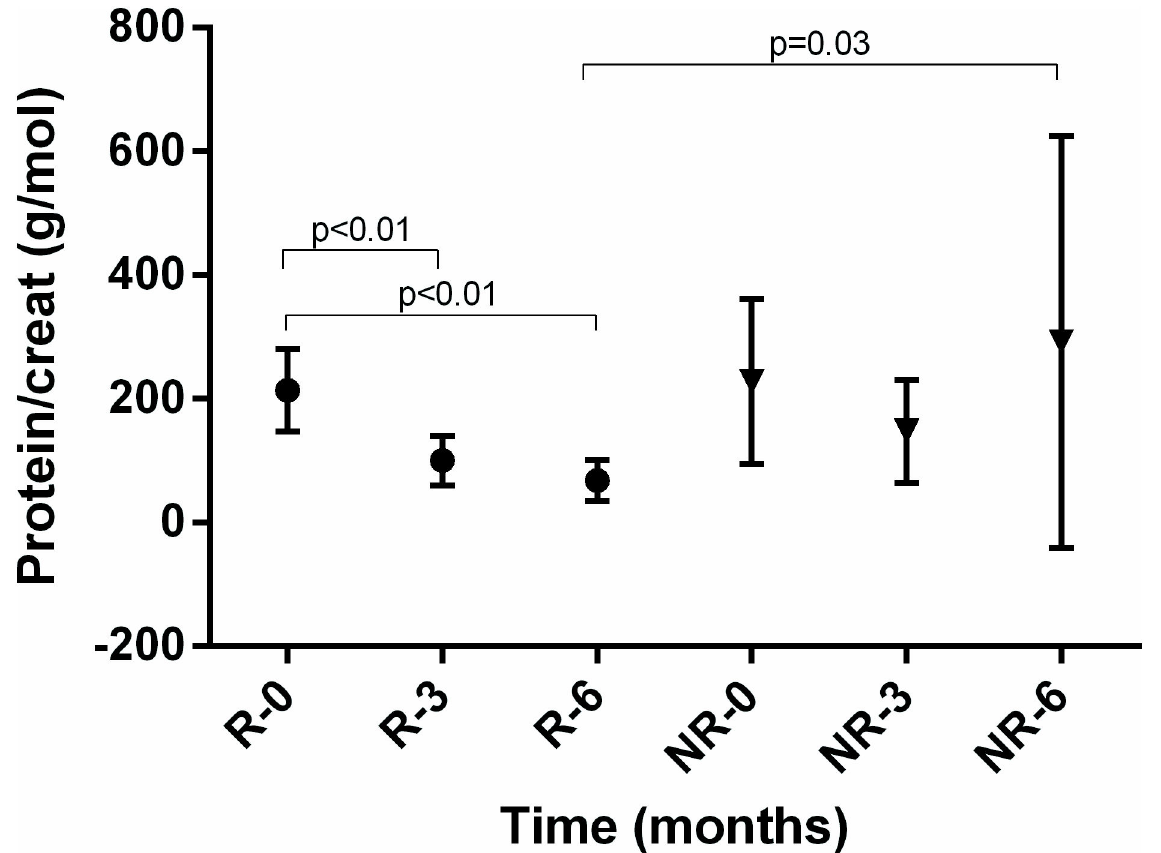
Figure 1. Mean urine protein to creatinine ratio in responders (R) and non-responders (NR) in time. doi: